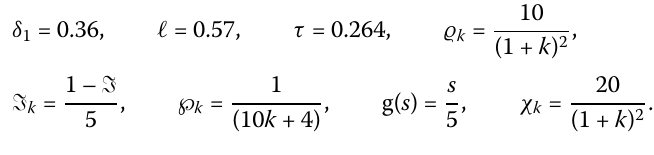
(5) Algorithm 2 (briefly, IM-EGM